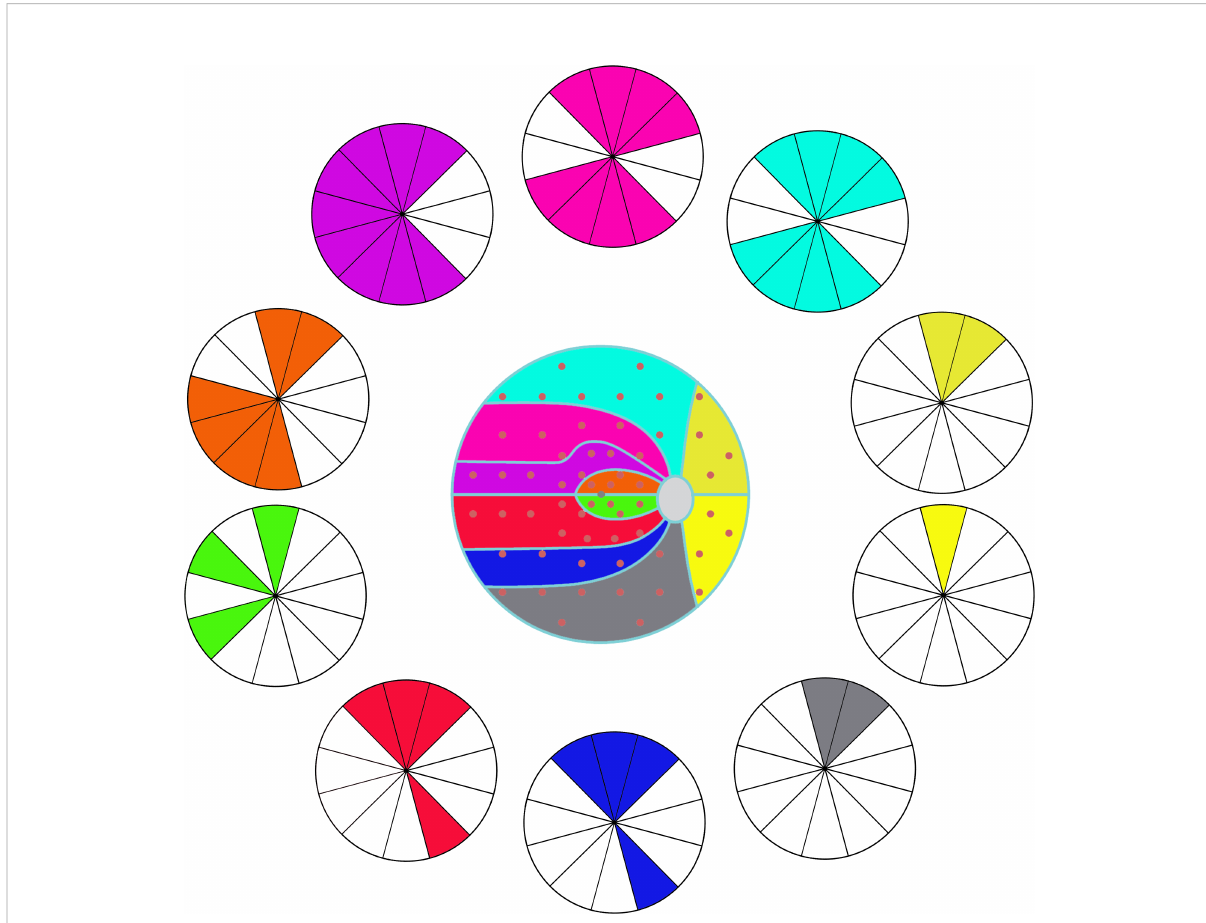
FIGURE 2 The correlation between visual fi eld (VF) clusters and retinal nerve fi ber layer (RNFL) clock-hour sectors. The same color indicates the correlation (coef fi cient value more than 0.45, Pearson ’ s Correlation Analysis) between VF clusters and RNFL